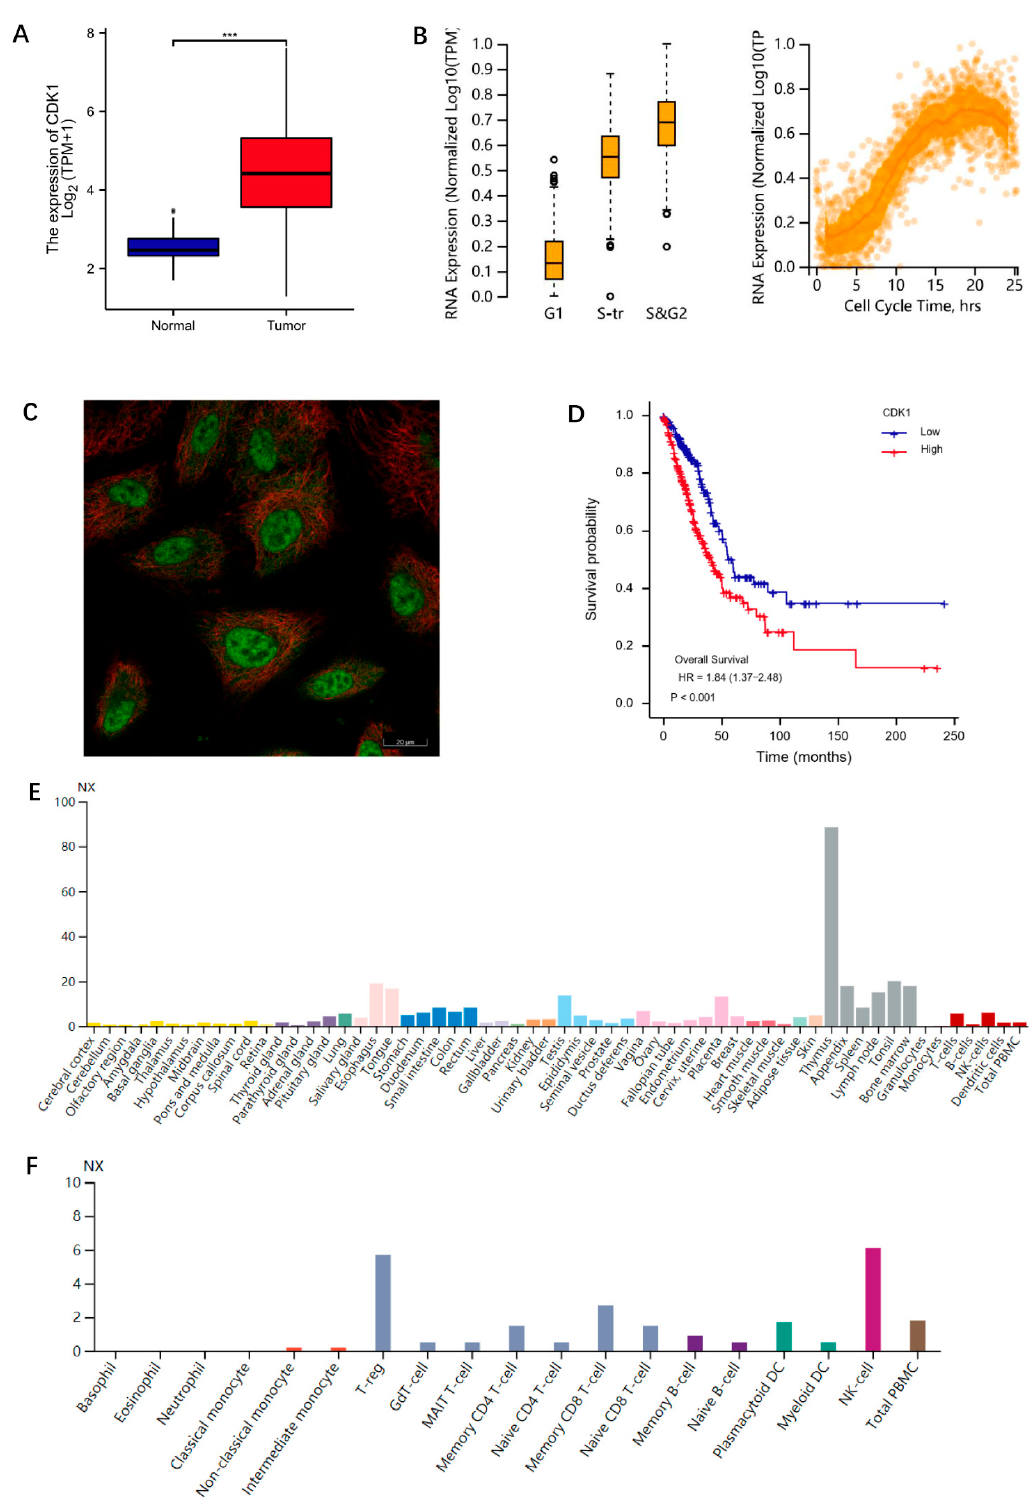
Figure 1. Information for CDK1. ( A ) CDK1 expression in normal tissues and LUAD. Significance markers: *** p < 0.001. ( B ) The expression of CDK1 changed during the cell cycle. ( C ) The localization of CDK1 in A549 cell. Green for CDK1 antibody; red for tubulin. ( D ) Correlation between CDK1 expression and OS of LUAD patients. ( E ) Tissue-specificity analysis. ( F ) The results of CDK11 expression levels in blood cell samples. The analysis data of ( A , D ) were from TCGA database. The analysis data of ( B , C , E , F ) were from HPA